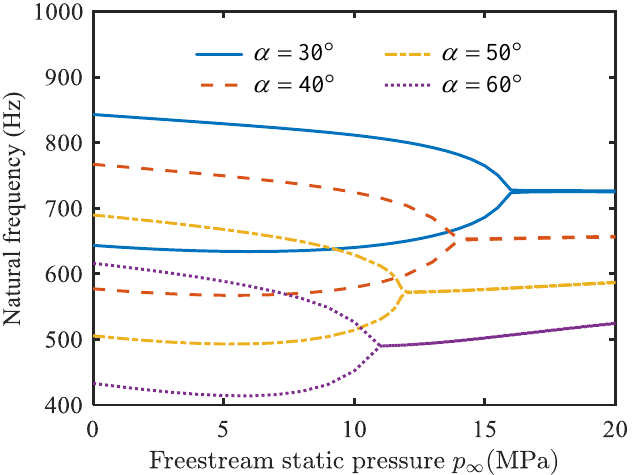
Figure 10. Influence of semi-vertex angle of conical shell on critical free-stream static pressure ( p = 1).